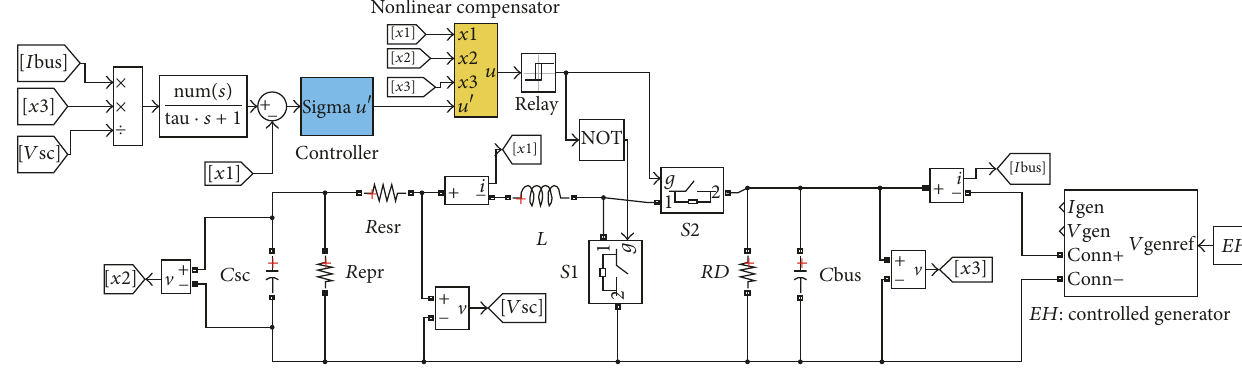
Figure 5: Detailed simulation scheme.